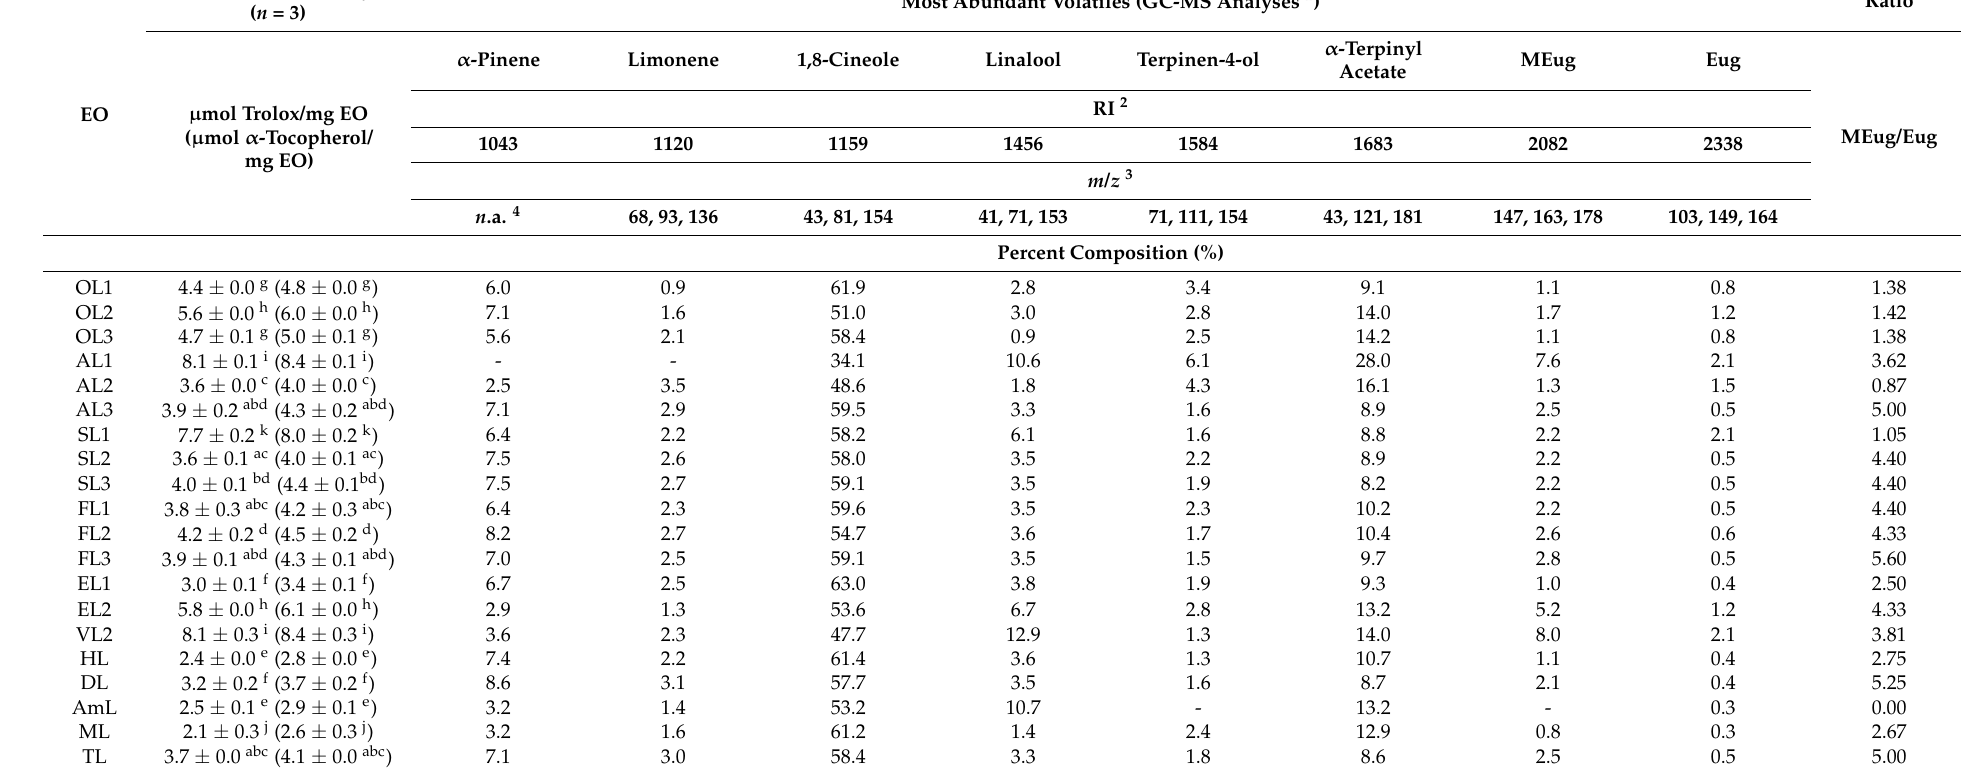
Table 5. Antioxidant activity of bay laurel essential oils (EOs) expressed as Trolox (or α -tocopherol) equivalents, GC-FID percent composition (%) of their most abundant components, and MEug/Eug